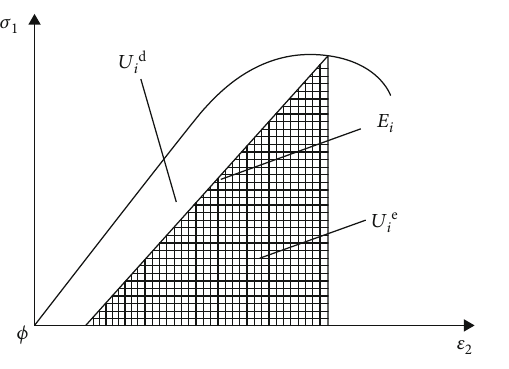
Figure 6: Relationship between dissipation energy U id and releasable strain energy U ie in the rock